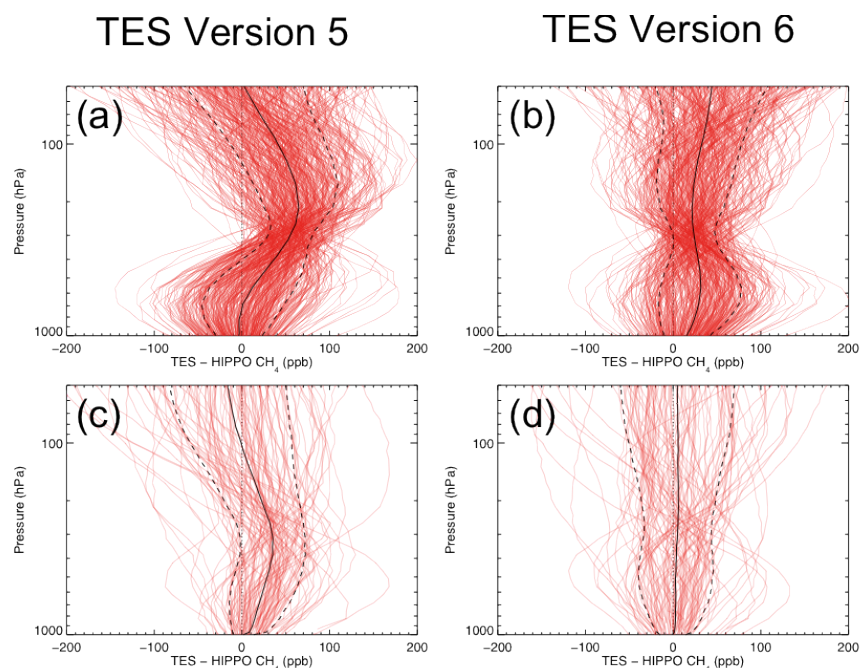
Figure 6. The differences between the N 2 O-corrected TES CH 4 retrievals (see Eq. (5) and Worden et al., 2012) and the HIPPO CH 4 profiles versus pressure (altitude). Red lines are the differences for individual TES retrievals. The solid black line is the mean difference and the dashed black lines show the standard deviation. Panels (a) and (c) are the TES Version 5 CH 4 retrievals with DOFS ≥ 1.6 and DOFS < 1.6, respectively. Panels (b) and (d) are the TES Version 6 CH 4 retrievals with DOFS ≥ 1.6 and DOFS < 1.6, respectively.